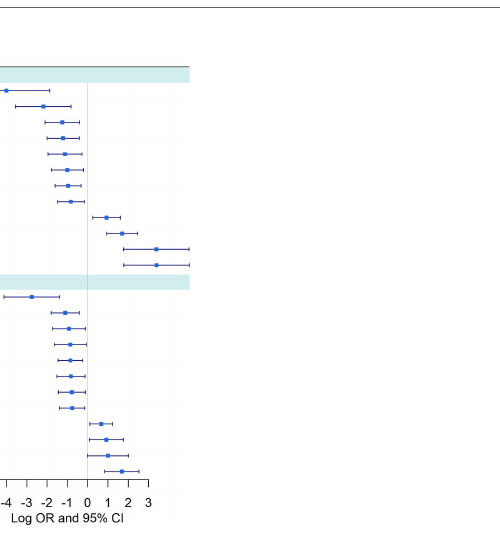
FIGURE 5 | Pairwise comparisons between Symptomatic vs. Asymptomatic/Mild in GC-MS and CE-MS metabolites. Multivariate logistic regression, adjusted for age and sex, was used to compare Symptomatic vs. Asymptomatic/Mild. The False Discovery Rate or FDR was used to cope with multiple testing, q-values are provided. Monostearin*, Monostearin/1-stearoyl-rac-glycerol. Isocitric Acid*, Citric Acid/Isocitric acid. D-Alanyl-D-Valine*, D-Alanyl-D-Valine/Glycyl-L-leucine/N2- Acetyl-L-Lysine.